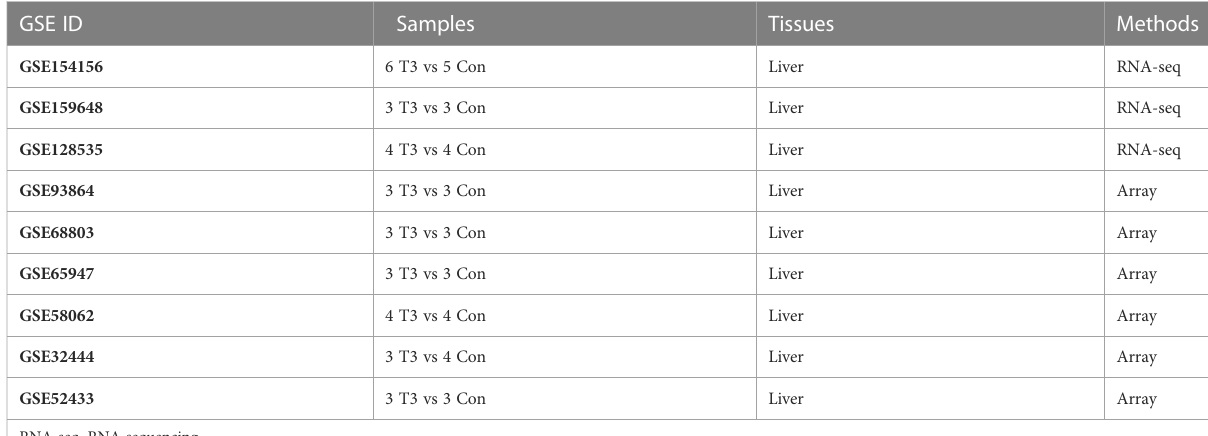
RNA-seq, RNA sequencing.